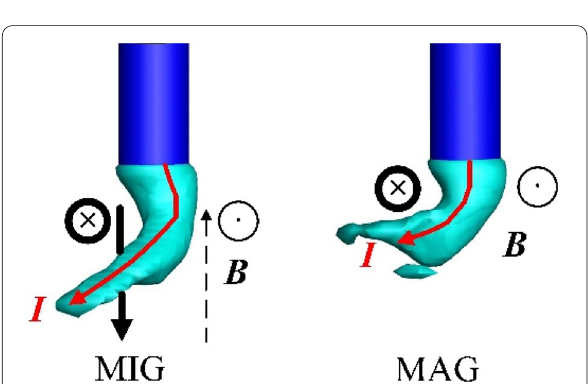
Figure 7 Rotating and swing mechanism in 500 A MIG and